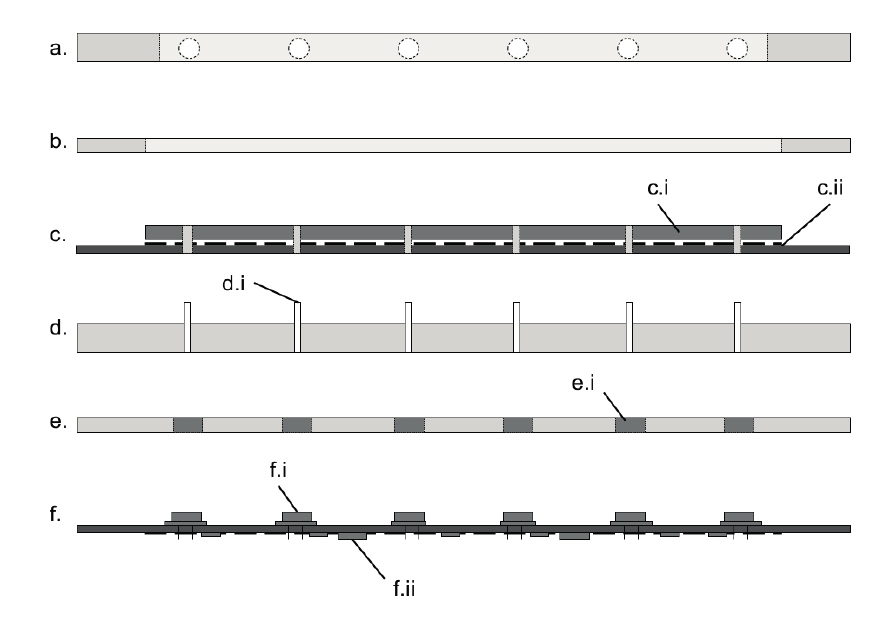
Figure 4. Schematic diagram showing the layers (exploded view) that form the device. ( a ) The 5 mm PMMA chip surround layer with LEDs shown in alignment holes, this layer holds the chip in place over the optical fibres (not shown) and aligns the LEDs with the reaction chambers; ( b ) The 3 mm PMMA layer that surrounds the isothermal plate; ( c ) The upper PCB layer with isothermal plate (c.i) glued in position above the SCOB element (dashed line, c.ii) and the PCB; ( d ) Optical fibre layer (PMMA) with 3000 μ m optical fibres (d.i) in place; ( e ) The filter PMMA layer which holds the long pass emission filter (e.i) in place over the photodiodes; ( f ) The lower PCB with photodiodes mounted on the upper surface (f.i) and the amplifcation circuitry on the lower surface